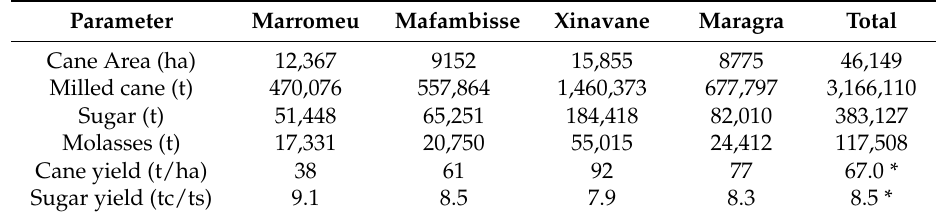
Table 1. Sugarcane mill and production parameters in Mozambique in 2013. Source: Cepagri [13].